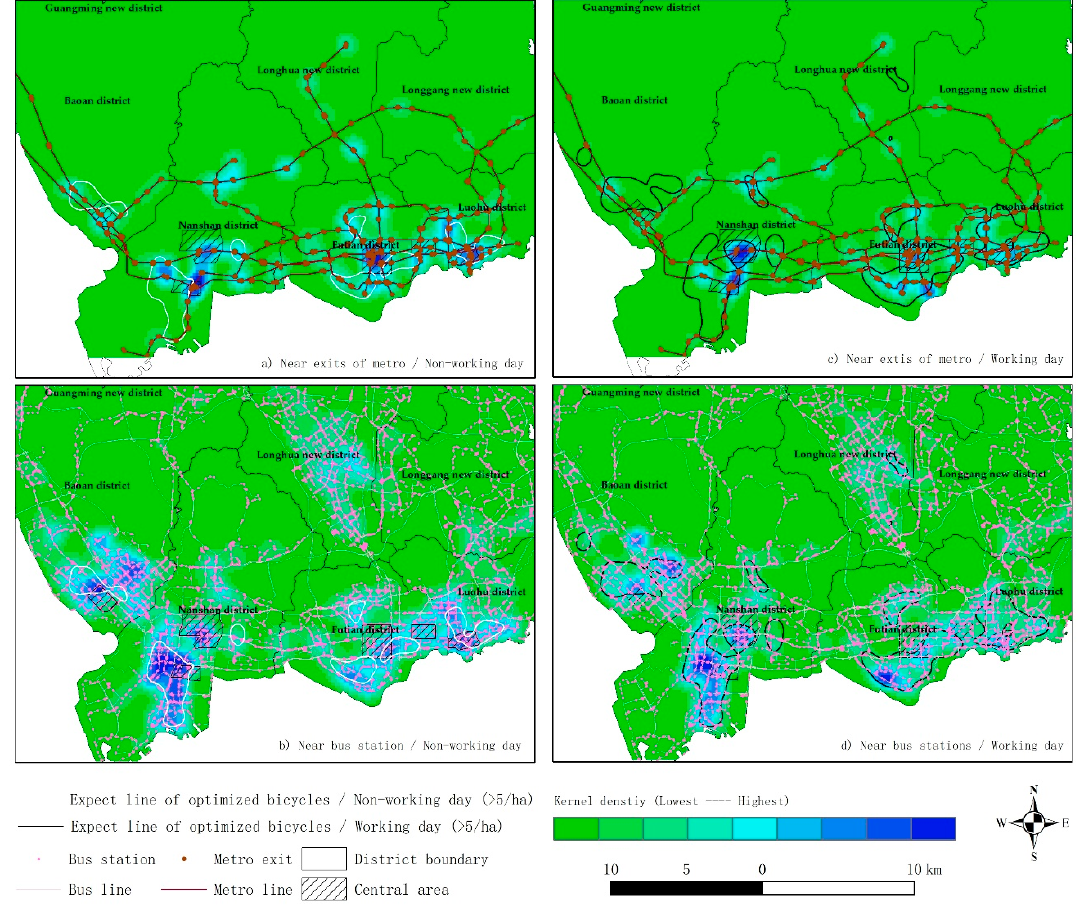
Figure 9. The spatial distribution of optimized bikes near public transportation facilities.